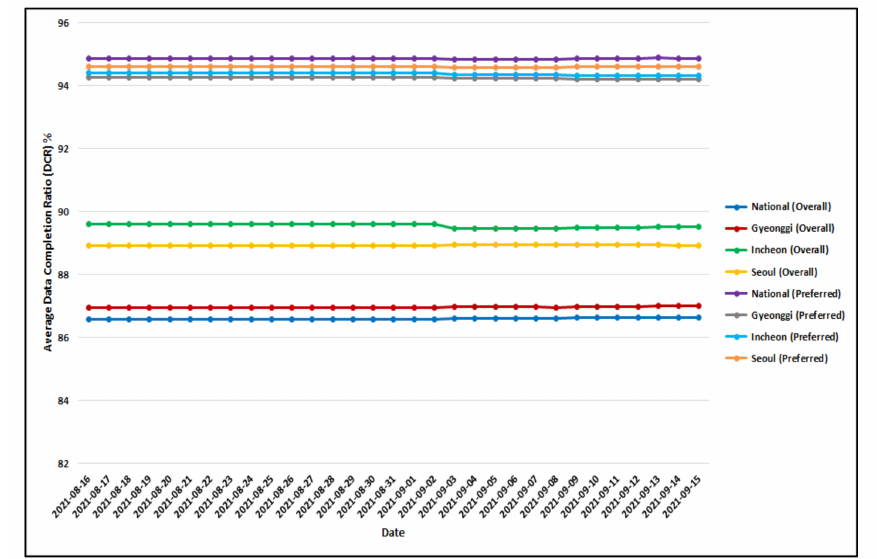
Figure 11. Daily average DCR of National and Greater Seoul